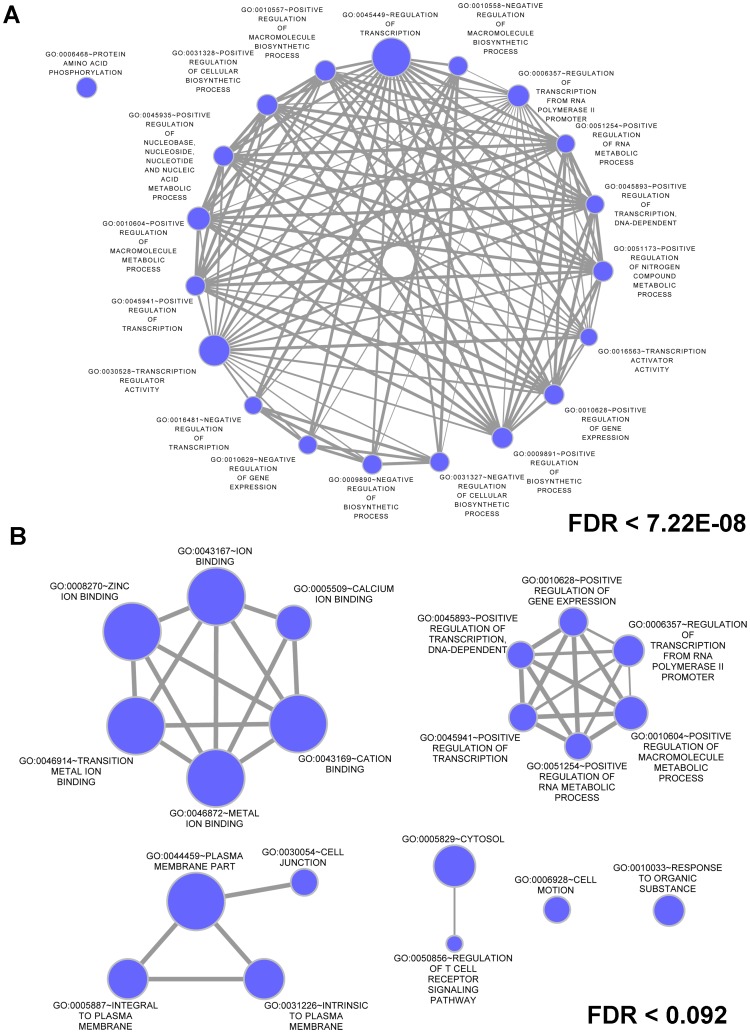
Graphs of top 20 enriched GO terms for miRNA targets.The top 20 enriched GO terms based on FDR (FDR levels shown) were graphed for gene targets of the top 10 expressed known miRNAs (A) or the validated novel miRNAs (B). GO terms related to the regulation of transcription, metabolic processes, and biosynthetic processes were highly represented among the known miRNA targets and form a connected graph consisting of 19 of the top 20 GO terms (A). A connected graph of terms related to regulation of transcription and metabolic processes was also present for targets of the novel miRNAs (B). For the novel miRNA targets, connected graphs of terms related to the plasma membrane, “regulation of T cell receptor signaling pathway”, and ion binding were also identified. The enrichment for “calcium ion binding” is of particular interest given the importance of calcium as a constituent of breast milk. Graphs were generated using the Cytoscape [47] Enrichment Map plugin [48].